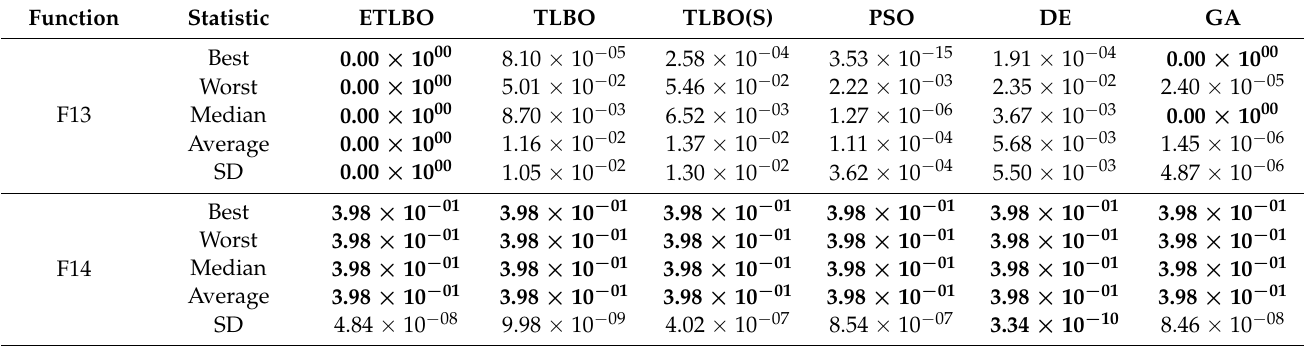
Table 4. Simulation results of multimodal